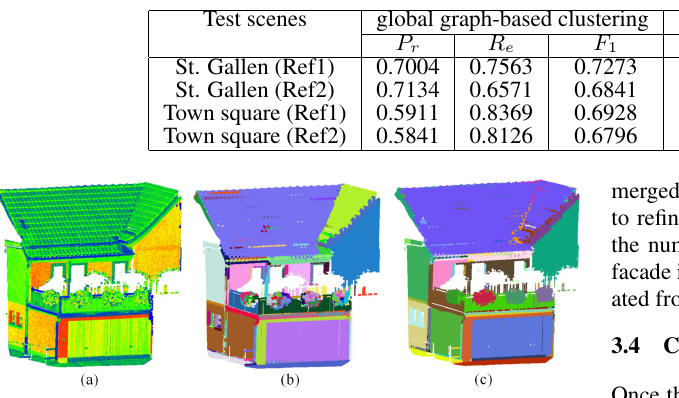
Table 1. Comparison of segmentation results using global graph-based clustering (global graphical model) and the unsupervised hierarchical clustering (local graphical model).